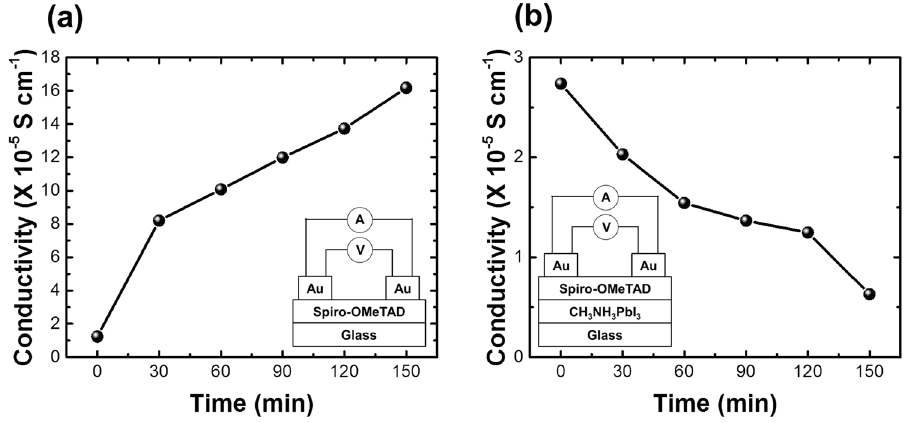
Figure 3. Dark conductivity of ( a ) spiro-OMeTAD and ( b ) MAPbI 3 /spiro-OMeTAD at 85 °C with time. Four- point probe measurement was used for the conductivity analysis. Inset shows structures for the measurement of conductivity of spiro-OMeTAD, glass/spiro-OMeTAD/Au, and glass/MAPbI 3